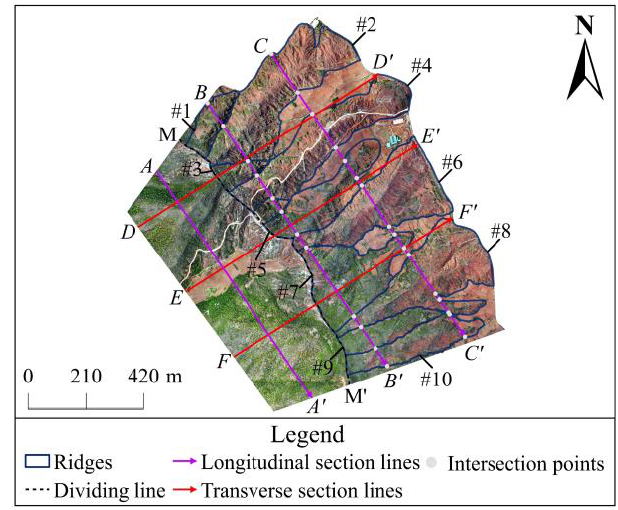
Figure 7. The distribution of the longitudinal and transverse section lines.